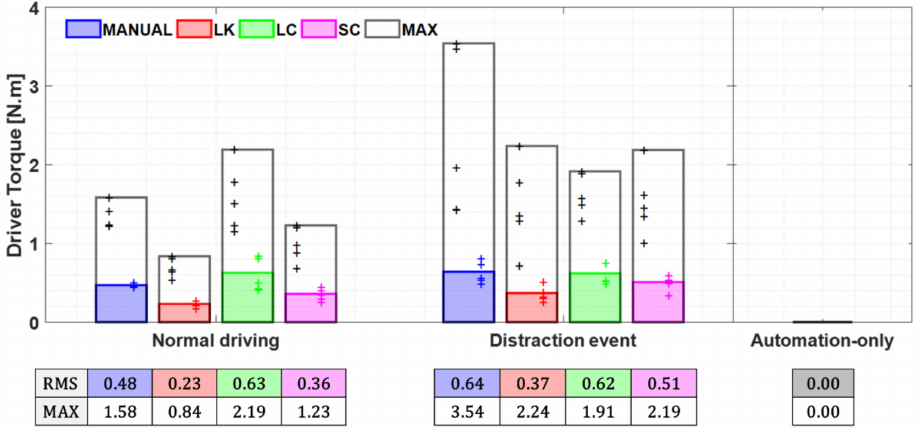
Figure 13. Driving efforts statistics (RMS and MAX of driver’s torque).